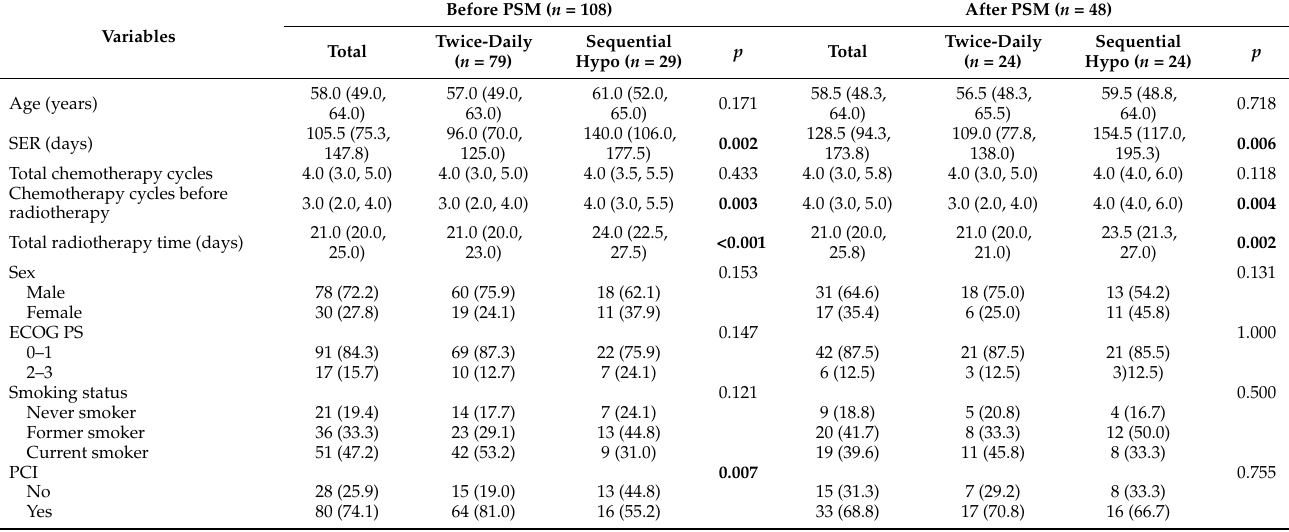
Table 1. Baseline characteristics for patients before and after PSM [M (QL, QU)/ n